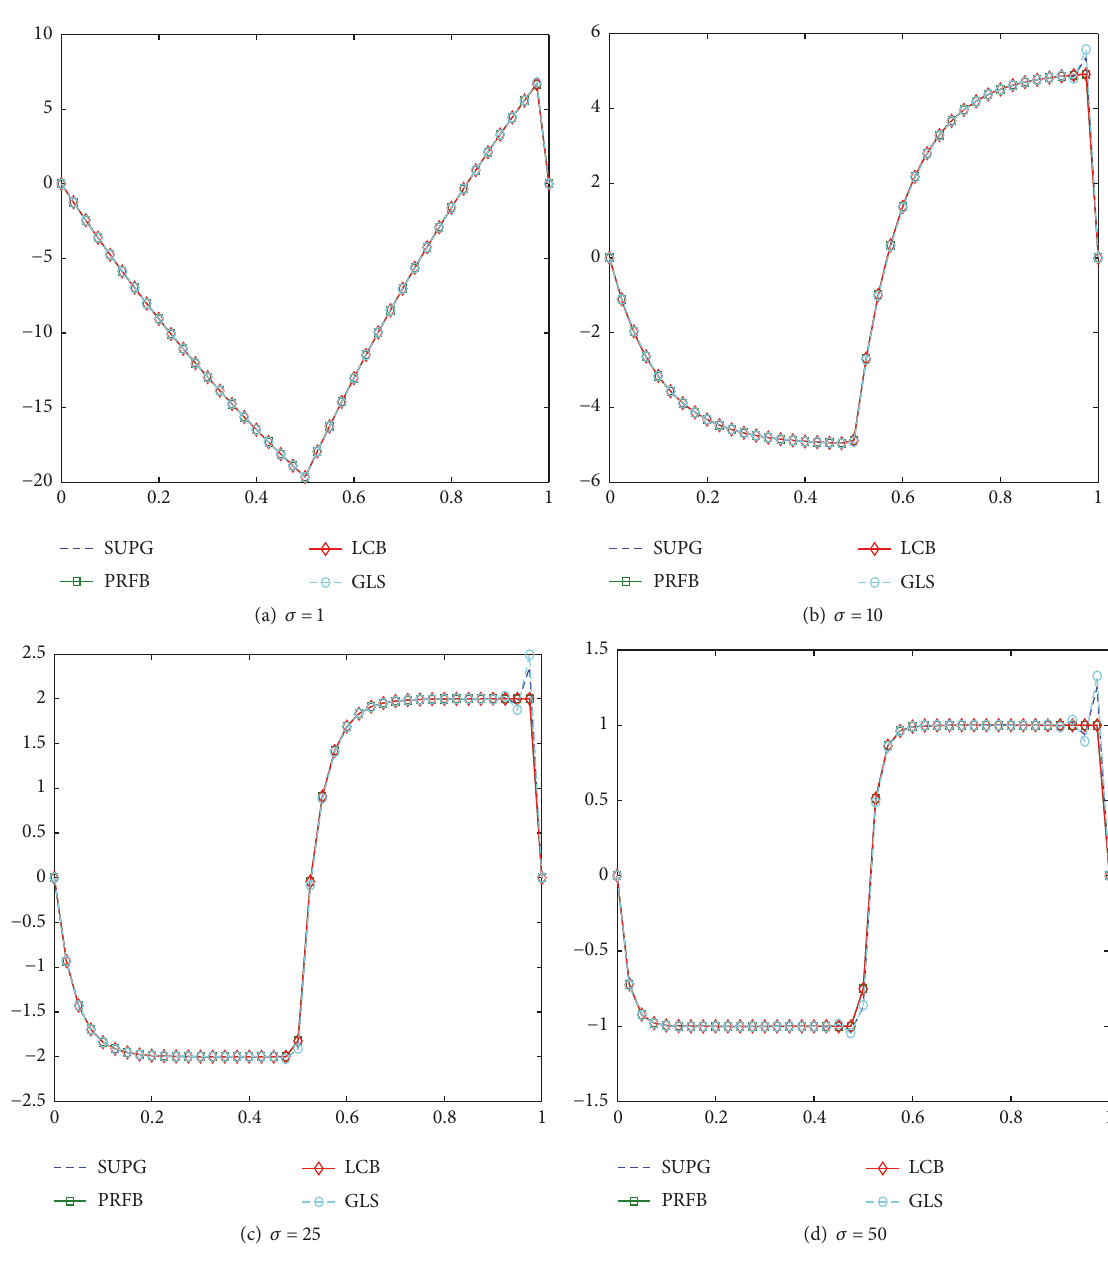
Figure 7: The numerical solutions for several values of 𝜎 when 𝜖 = 10 −5 and 𝛽 = 1 .